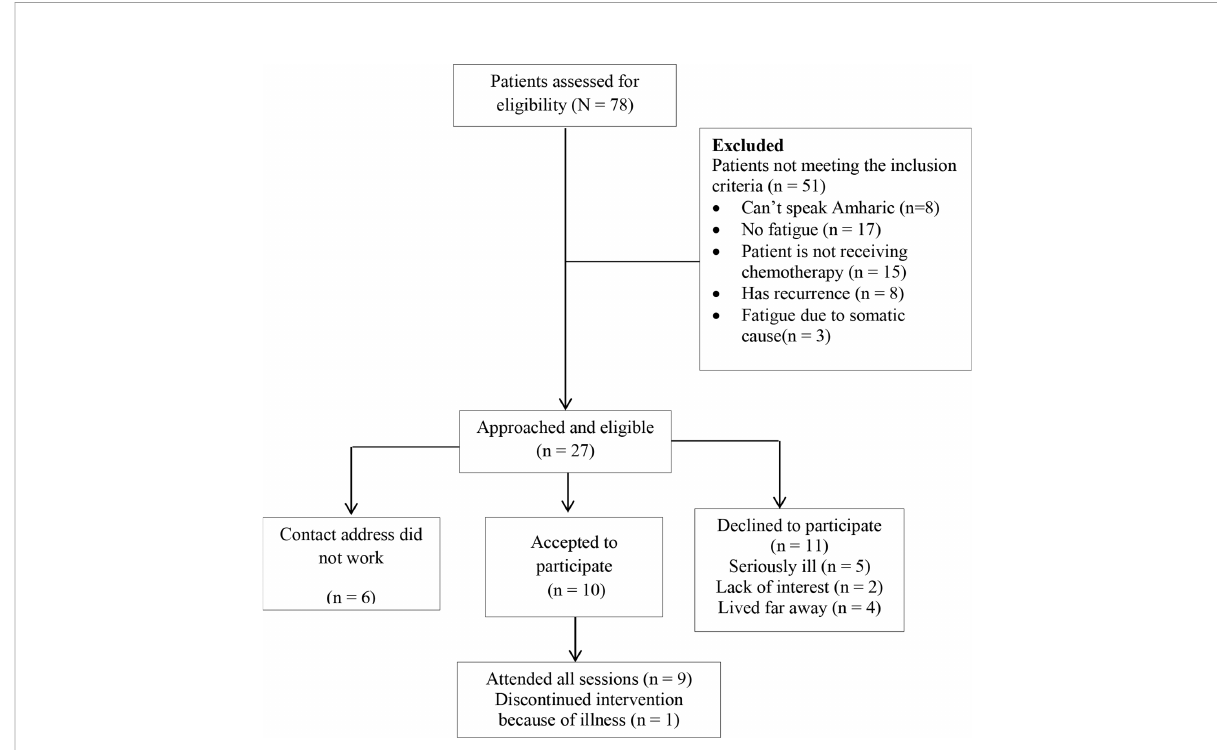
FIGURE 1 Cognitive behavioural therapy integrated with activity pacing (CBT-AP) patient recruitment CONSORT